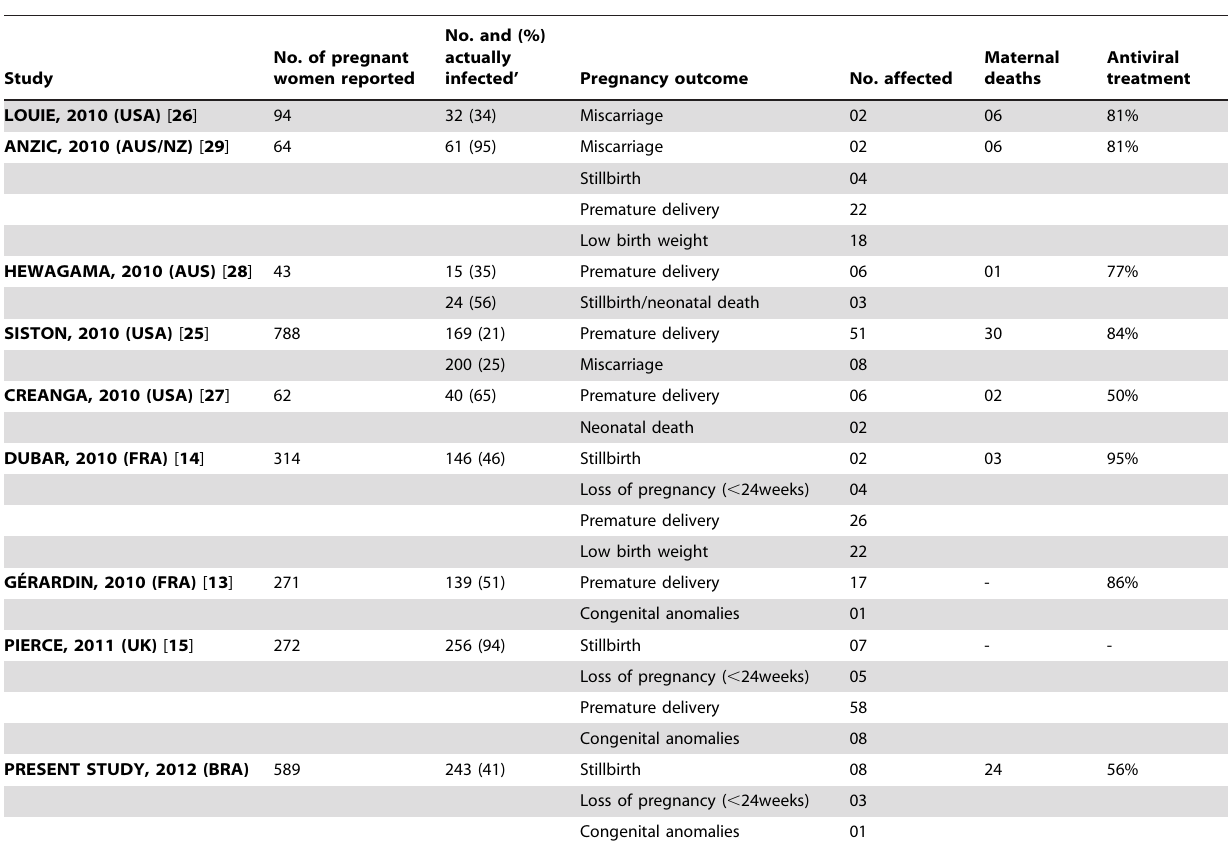
Table 3. Previous studies of pregnancy outcomes among women infected with the 2009 H1N1.